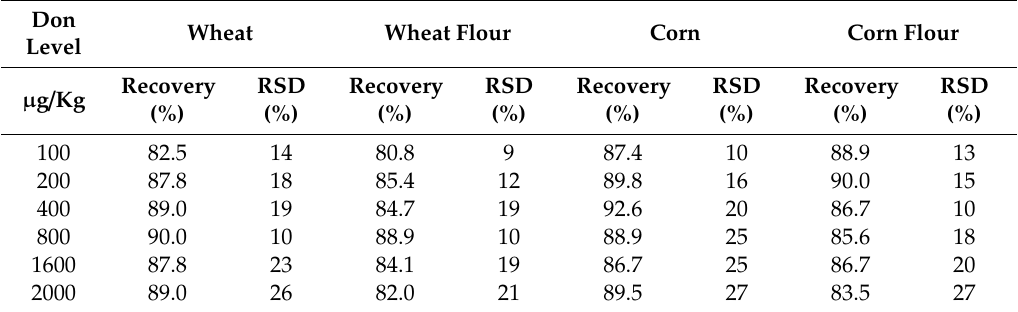
Table 1. Recovery percentage of deoxynivalenol (DON) in wheat, corn, wheat flour and corn flour samples. Don Wheat Wheat Flour Corn Corn Level